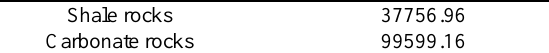
Table 1. Area Data for Different Rock Types in